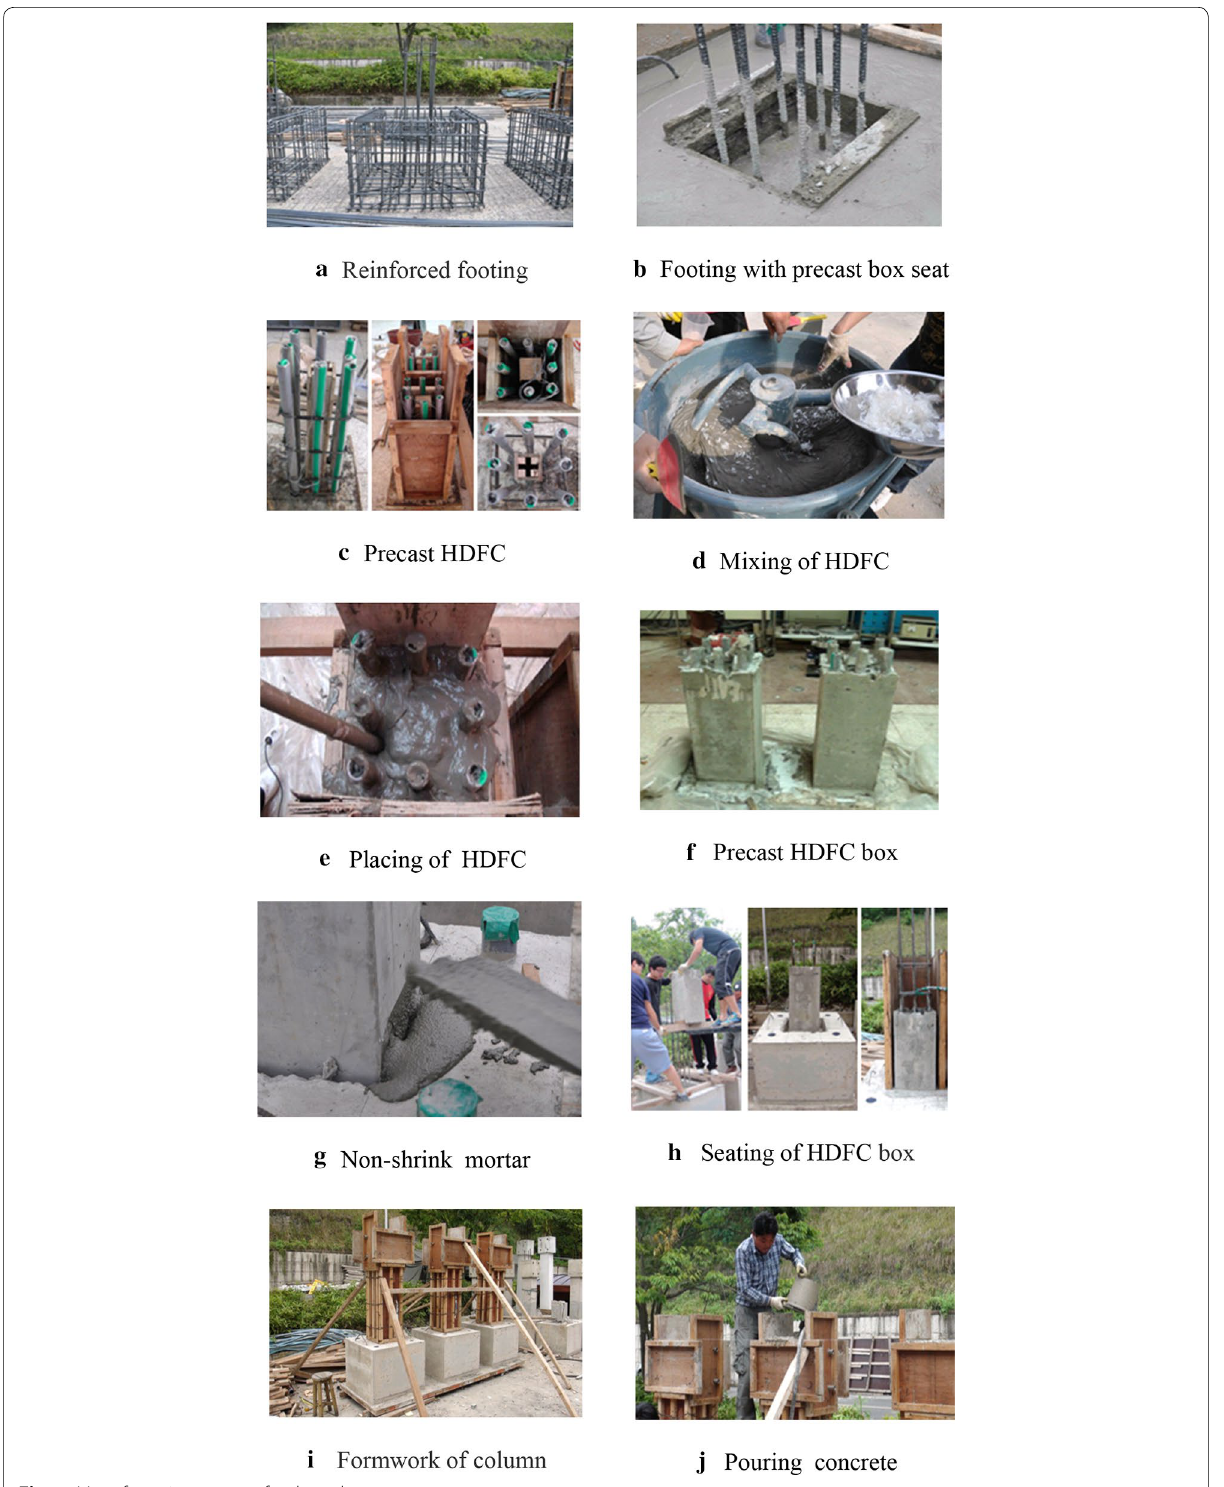
Fig. 7 Manufacturing process for the